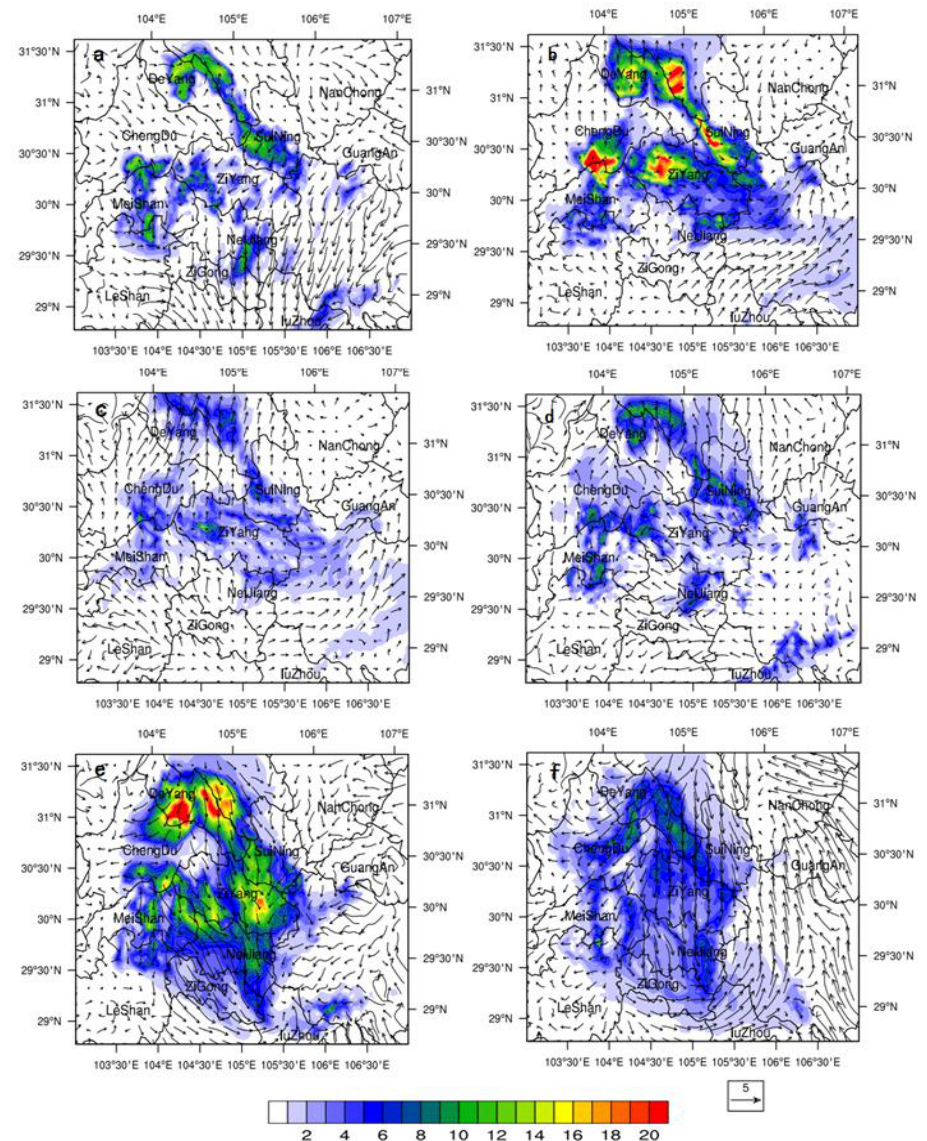
Figure 11. Spatiotemporal change in the volume fraction of ground pollutants (10 − 4 ) and the 10-m wind field (m · s − 1 ) in the study area: ( a ) 1200 UTC on 6 May; ( b ) 0000 UTC on 7 May; ( c ) 0400 UTC on 7 May; ( d ) 1200 UTC on 7 May; ( e ) 0000 UTC on 8 May; and ( f ) 0400 UTC on 8 May.